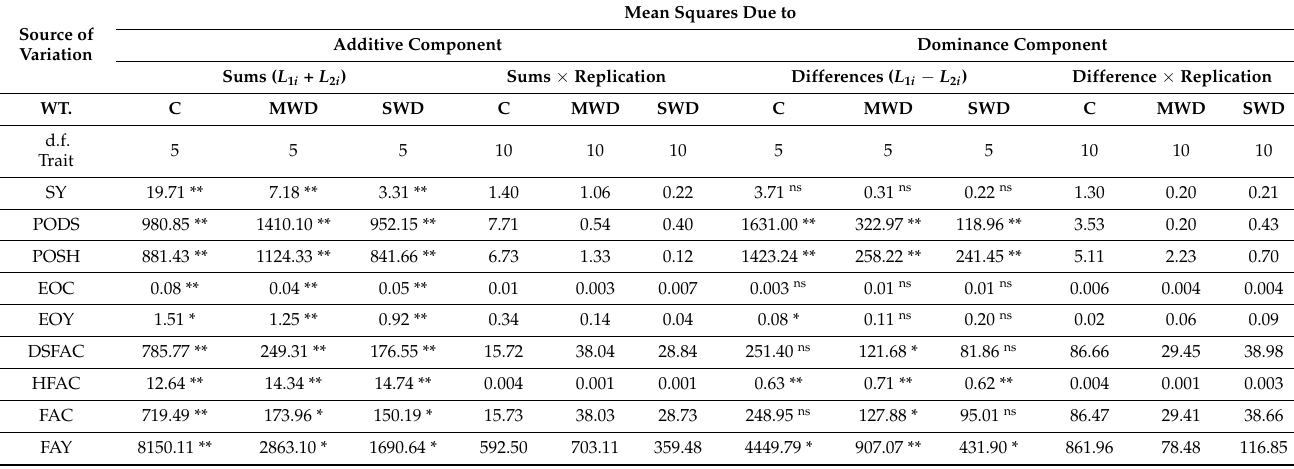
Table 4. Analysis of variance for additive and dominance components for different traits (within water treatments) in coriander under control (C), moderate water deficit (MWD), and severe water deficit (SWD) treatments. Source of